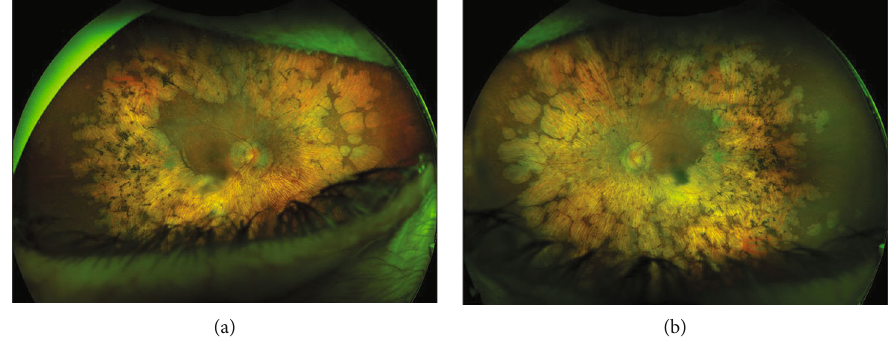
Figure 1: ultra-wide fi eld fundus photos of the (a) right eye and the (b) left eye showing pale and waxy optic nerve head with clear boundaries and area of atrophy peripapillary, paving-stone degeneration, drusen-like retinal deposits, bone spicule-like pigmentary clumping, and attenuated retinal vessels at mid- and far periphery.